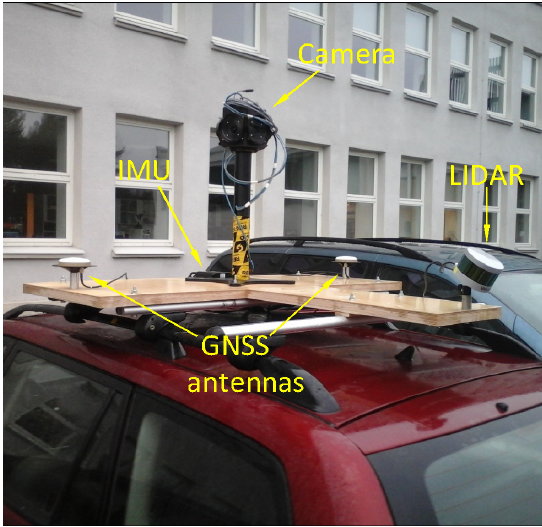
Figure 3. MLS point cloud of the study area. Colours show the calibrated reflectivities of surveyed